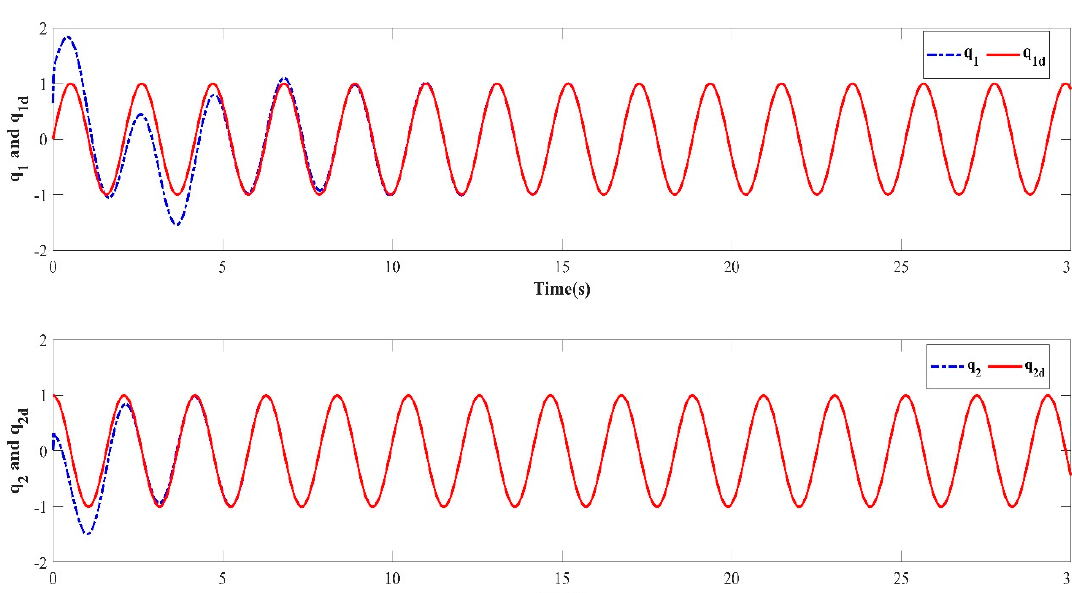
Figure 4. Learning trajectory in the third iteration.